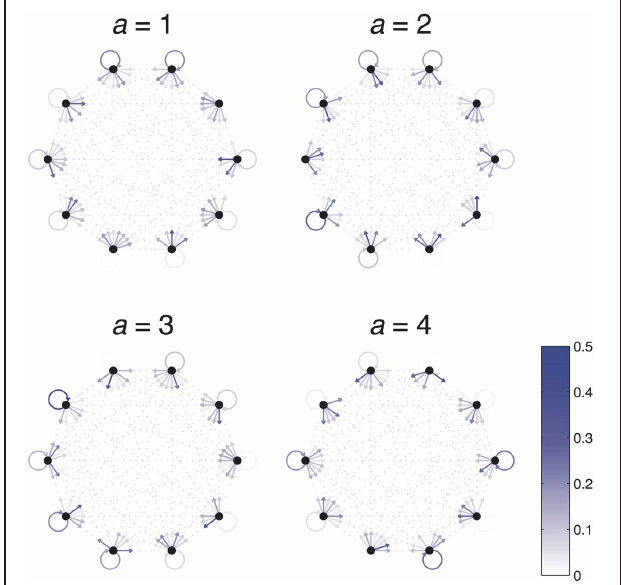
FIGURE A1 | Example Dense World. Dense Worlds consist of 4 actions (separately depicted) and 10 states (depicted as nodes of the graphs). The transition probabilities associated with taking a particular action are depicted as arrows pointing from the current state to each of the possible resultant states. Arrow color depicts the likelihood of each